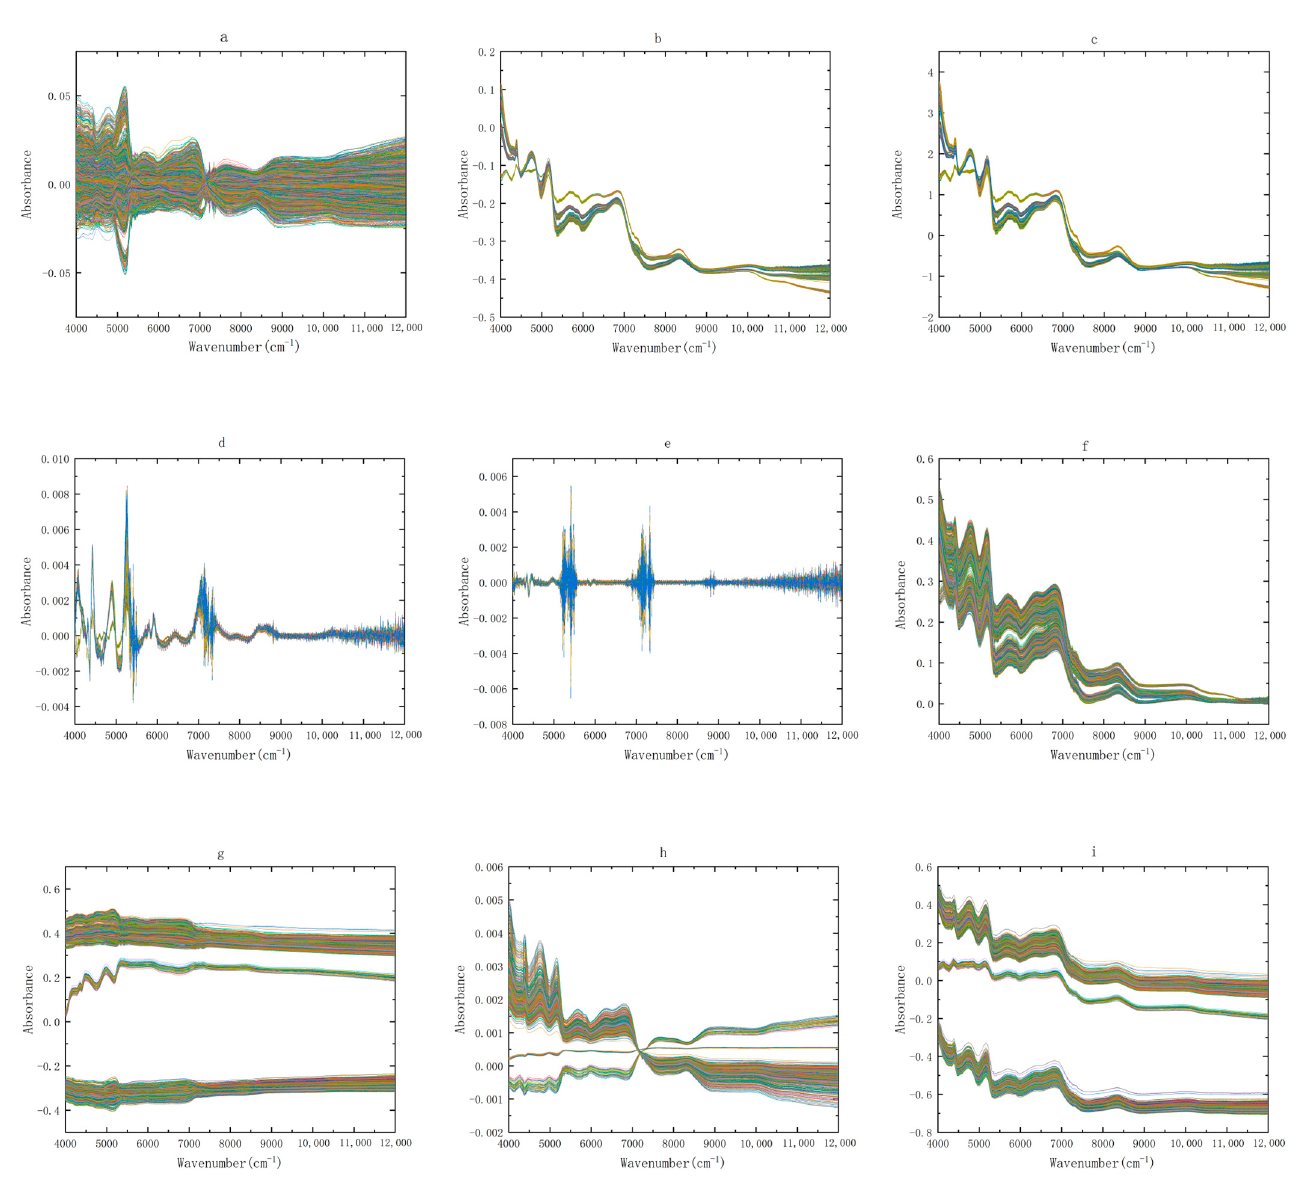
Figure 3. NIR spectra of non-Zhejiang Ophiopogon japonicus by nine preprocessing methods, ( a ) OSC, ( b ) MSC, ( c ) SNV, ( d ) first derivative, ( e ) second derivative, ( f ) baseline correction, ( g ) mean centering, ( h ) area normalization, and ( i ) Savitzky-Golay smoothing. Each color represents a sample of Ophiopogon japonicus .